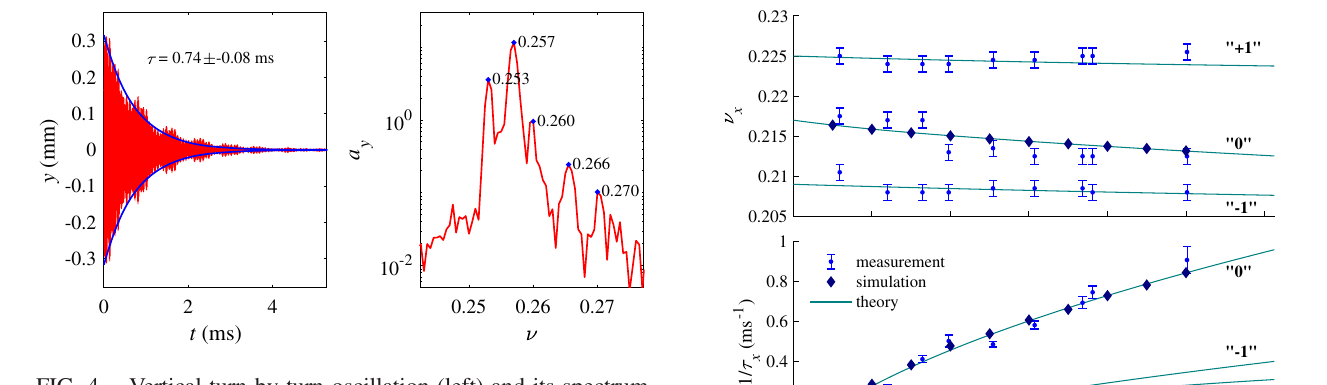
¼ 2 . 1 ; feedback off. x